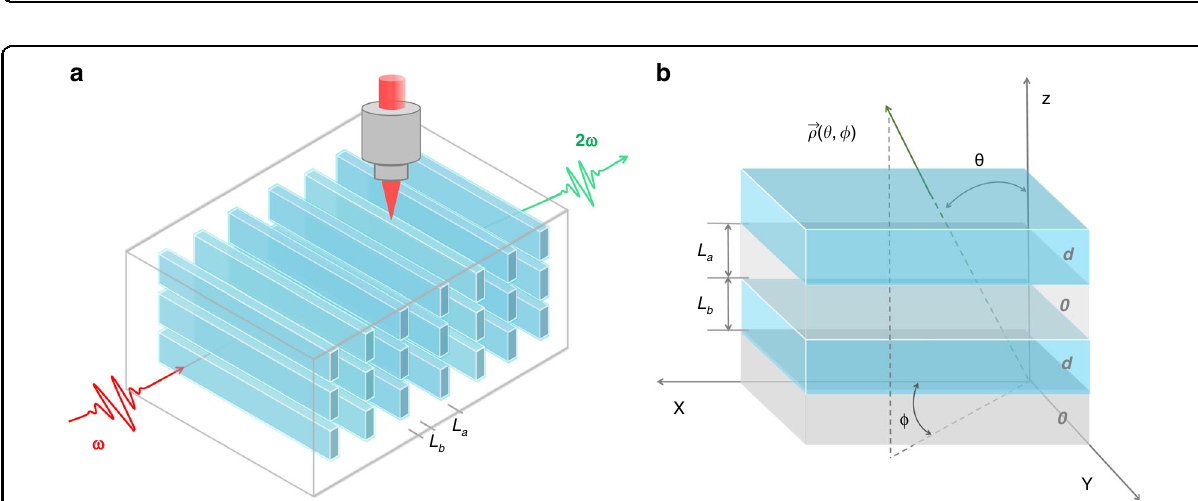
Fig. 3 Angular APP phase-matching engineering diagram. a Schematic of laser direct writing of APP gratings. Multiple grating layers can be fabricated along the depth direction to obtain large-scale APP crystals. Λ = L a + L b is the fabricated APP grating period, and L a and L b are the lengths of crystalline/amorphous regions of the crystal with second-order nonlinear coef fi cients of d /0, respectively. b APP gratings along the Z direction. ~ ρ θ ; ϕ ð Þ is the propagation direction of the interacting waves; θ is the phase-matching angle between the propagation direction and optical axis; and ϕ is the azimuth